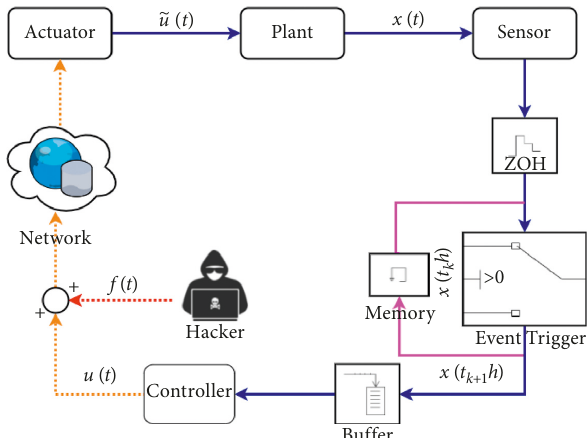
Figure 2: Networked control system under injection